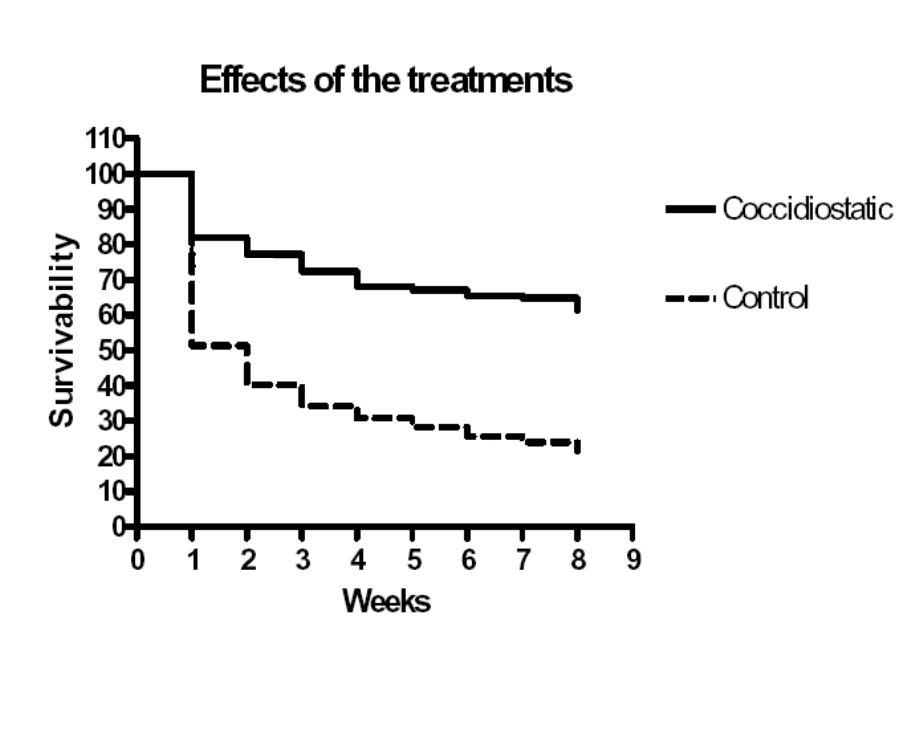
Figure 1:- effect of the treatment on chick survivability Discussion